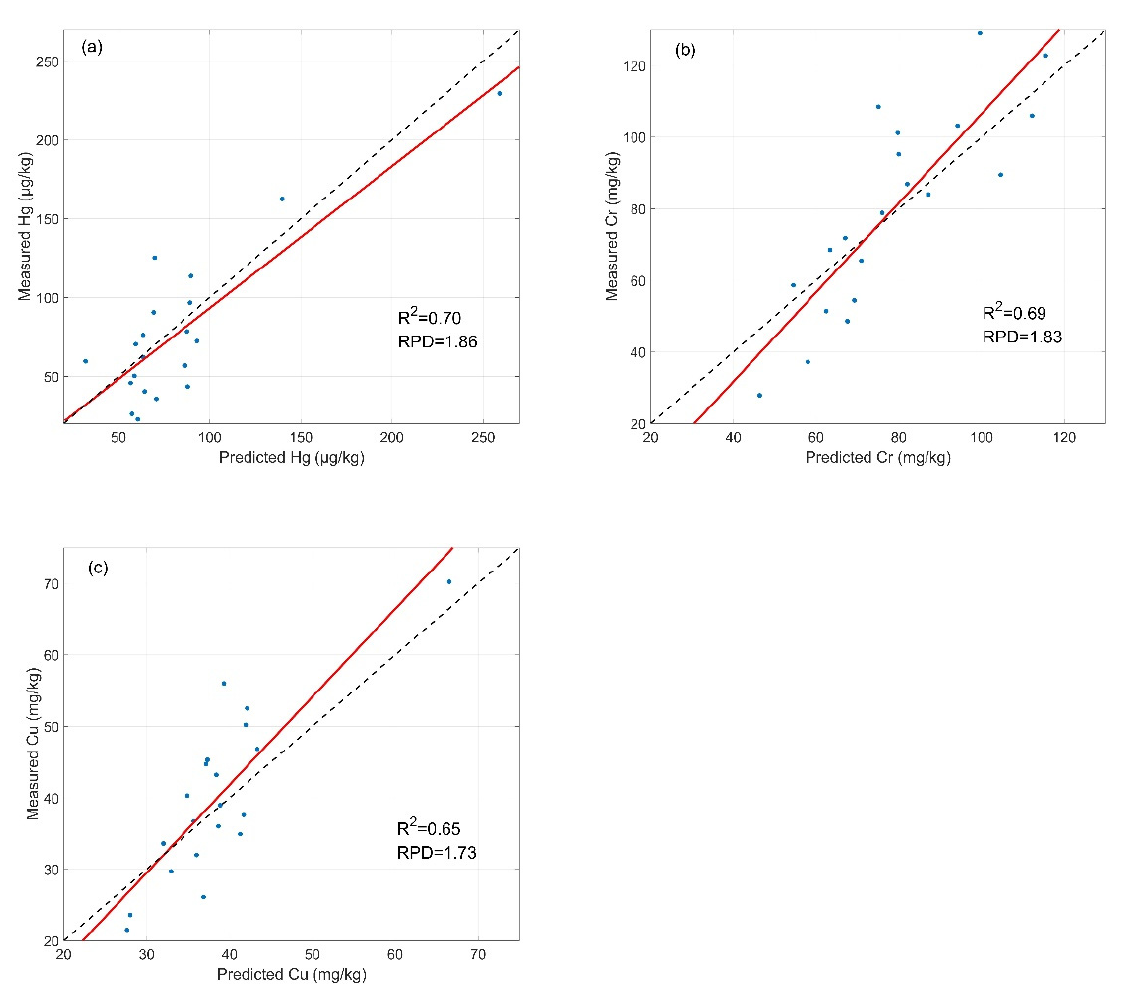
Figure 6. Scatterplots illustrating the optimal accuracy of ( a ) Hg, 1.8-order reflectance generalized regression neural network (GRNN) model; ( b ) Cr, 1.6-order reflectance random forest (RF) model; ( c ) Cu, 1.2-order reflectance GRNN model. The black dotted lines represent 1:1 lines, and the red solid lines represent the regression lines.